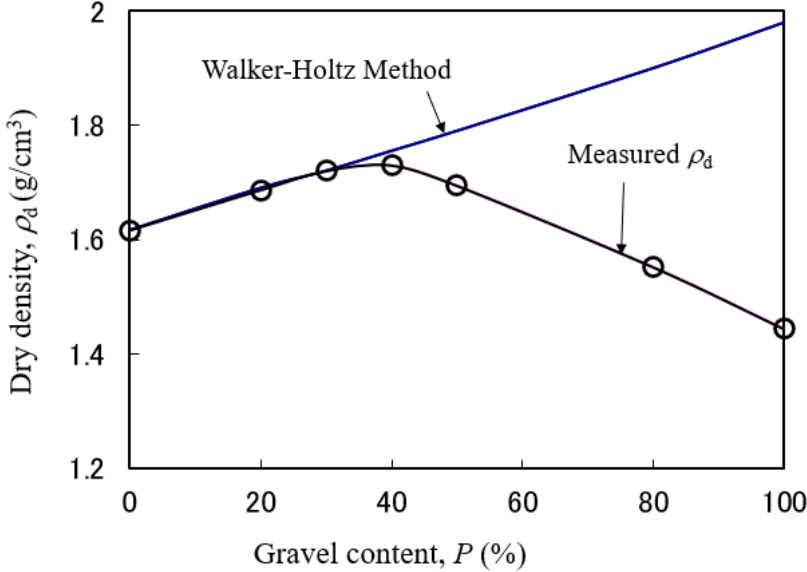
Figure 1. Limitation of Walker and Holtz (1951) [16] equation as presented by Ham et al. (2010) [20]. Ham et al. (2010) [20] employed the two-phase mixture theory suggested by Gutierrez (2005) [21] in an effort to study the influence of gravel content on initial dry density and compression index of D-G-S. In this theory, the overall void ratio e ( P ) of the mixed material is a function of the gravel content ( P ) by mass and is related to the void ratio of sand ( e s ) and void ratio of gravel ( e g ), as shown in Equation (1).